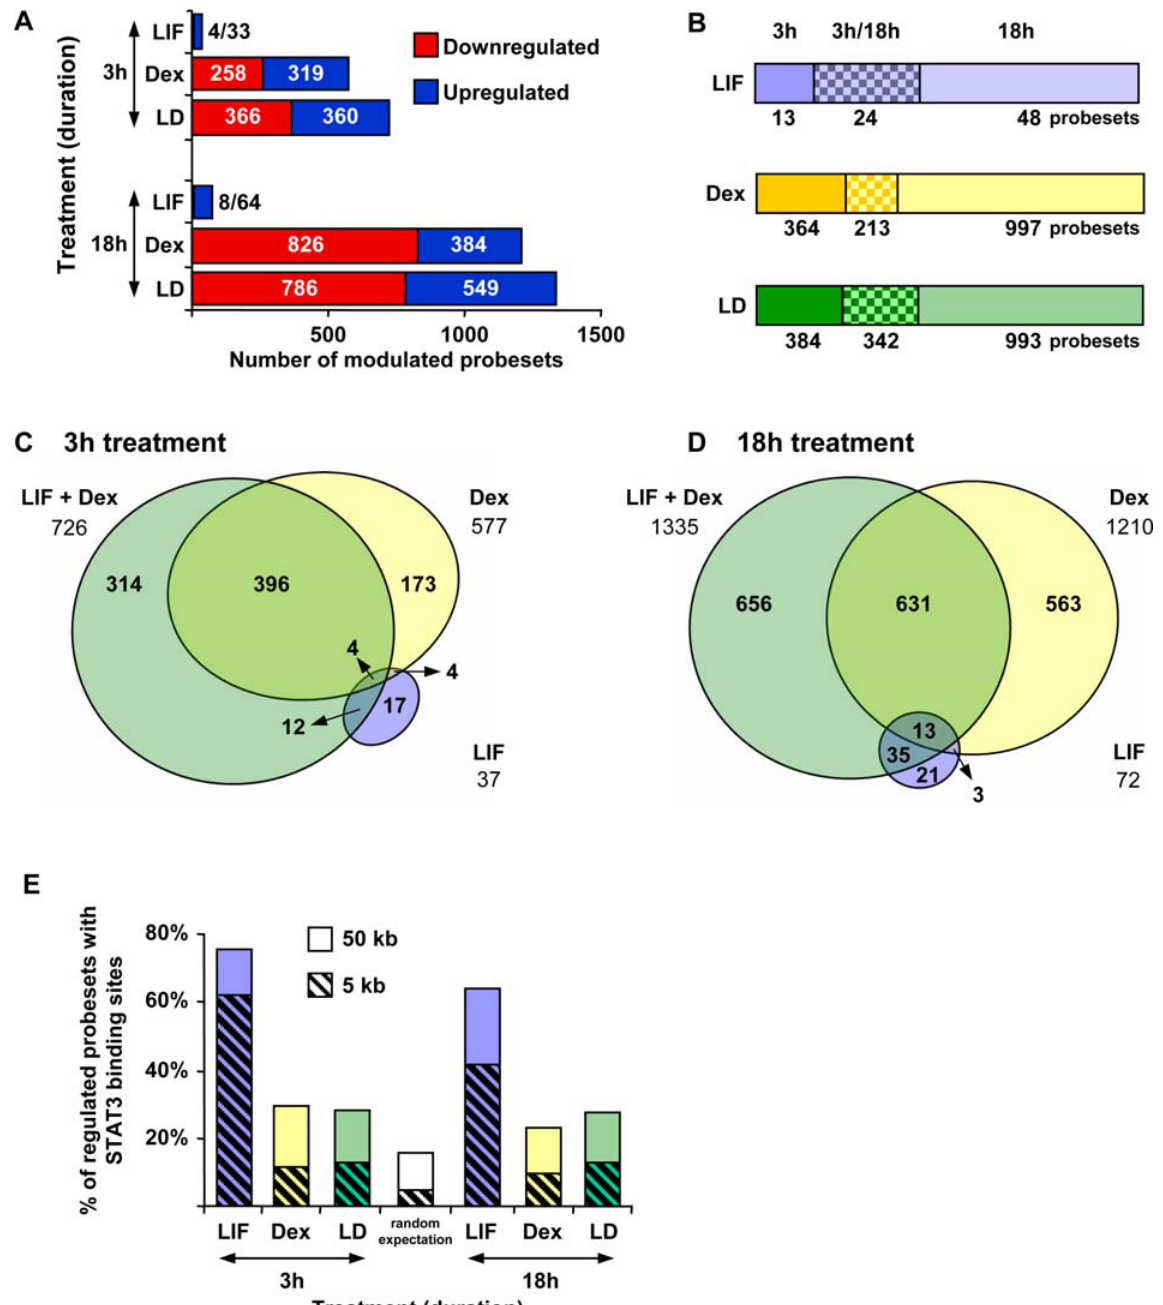
Figure 4. Identification of LIF and glucocorticoid regulated genes. A) AtT-20 cells were treated with LIF, Dex, both or vehicle and total RNA was extracted from cells after 3 h and 18 h of treatment. Affymetrix MOE expression arrays were used to assess expression levels for 45101 probesets in each condition. The expression profiling data were normalized with the GC-RMA algorithm and statistical analysis was measured by Local-pooled- error test (LPE). The replicate variance is , 0.001. Changes in gene expression levels in hormone-treated relative to control greater than 2-fold and for P # 0.05 were considered statistically significant. A total of 2396 probesets were thus identified, including all treatment conditions (Table S2). The bar histogram represents the number of probesets found to be up or down regulated in each condition. B) Bar diagram representing the number of probesets responding to treatment at either or both time points, for each condition. C–D) Venn diagram showing the overlap of probesets regulated by LIF, Dex or the combination at 3 h and 18 h of treatment. A large number of probesets were found to be uniquely regulated by both agents. E) Percentage of hormone regulated genes (probesets) that have at least one STAT3 binding site in the interval between 5 or 50 kb upstream or downstream of the gene. The random expectation value is calculated on all the genes present on the Affymetrix MOE 2.0 microarray. ment at about 22 kb upstream of the Lcn2 gene within an possibility that this STAT3 binding region might represent a intergenic region (Figure 6C) and no other gene is regulated by regulatory sequence for Lcn2 expression, we performed analytical either LIF and/or Dex in the Lcn2 vicinity. In order to assess the ChIP for STAT3 and GR in this genomic region using cells